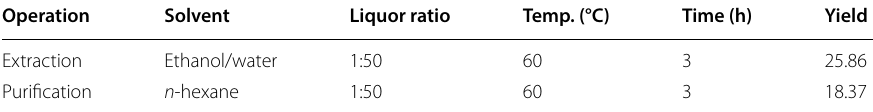
Table 1 Yield of extracted and purified B. ferruginea dye Operation